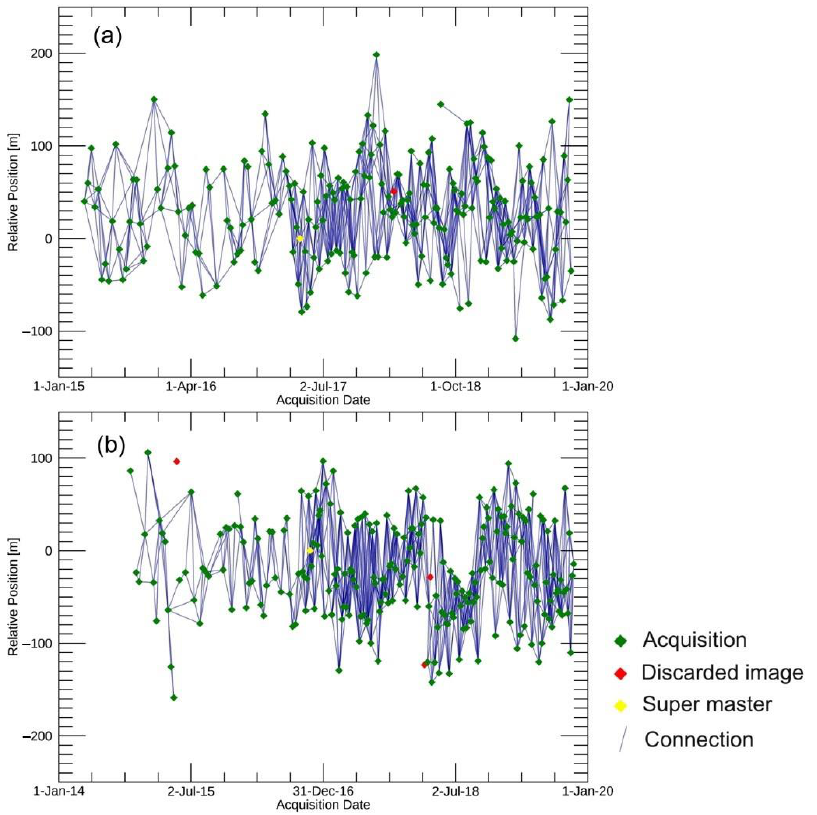
Figure 4. Connection graphs of the Sentinel-1 ascending ( a ) and descending ( b ) SAR images. Yellow point (super master) indicates the acquisition used to co-register all